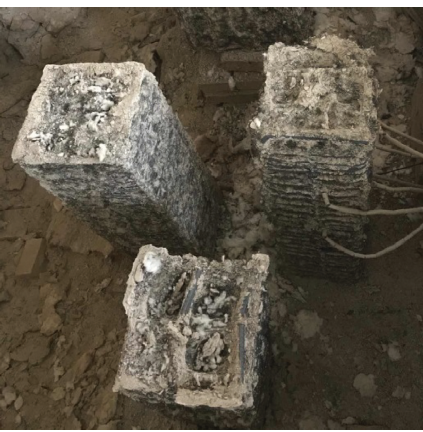
Figure 1: Spalling of RPC columns in